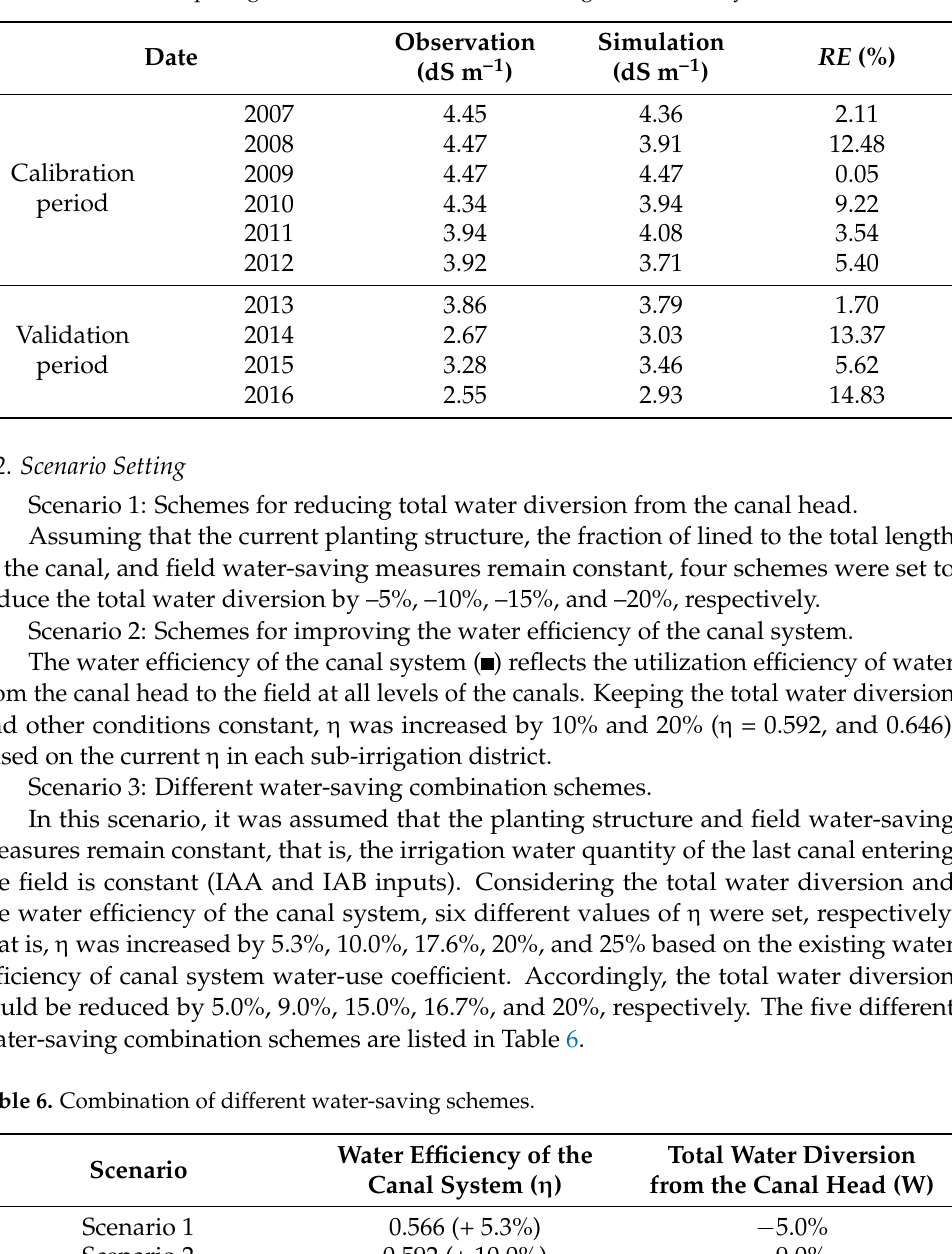
Table 5. Statistics comparing simulated and measured drainage water salinity.